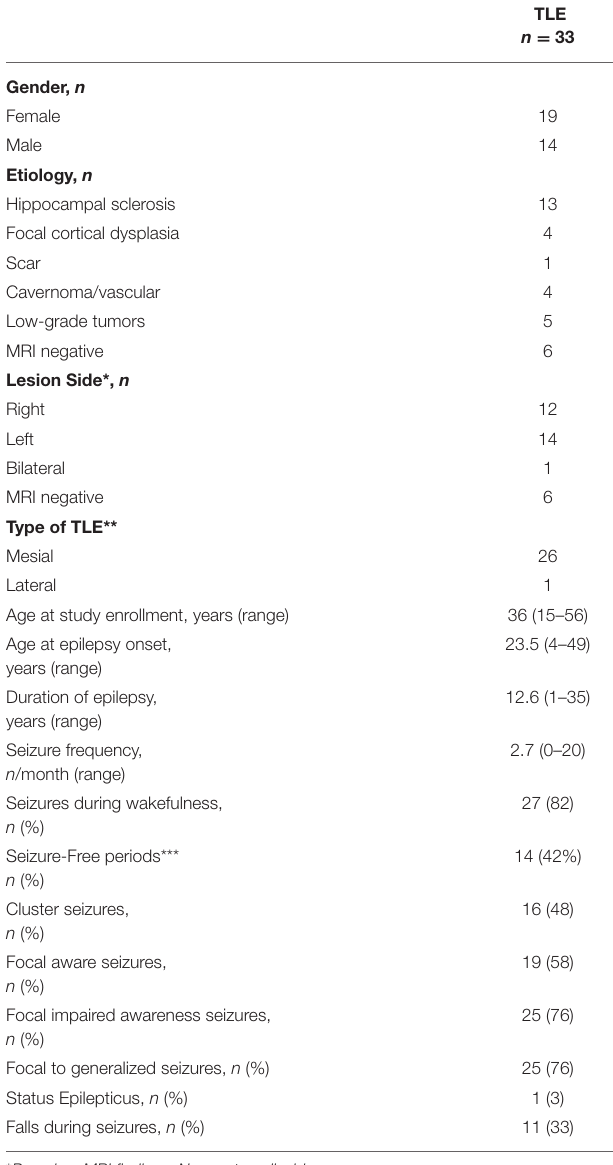
TABLE 1 | Electro-clinical data of the patients with temporal lobe epilepsy included in the